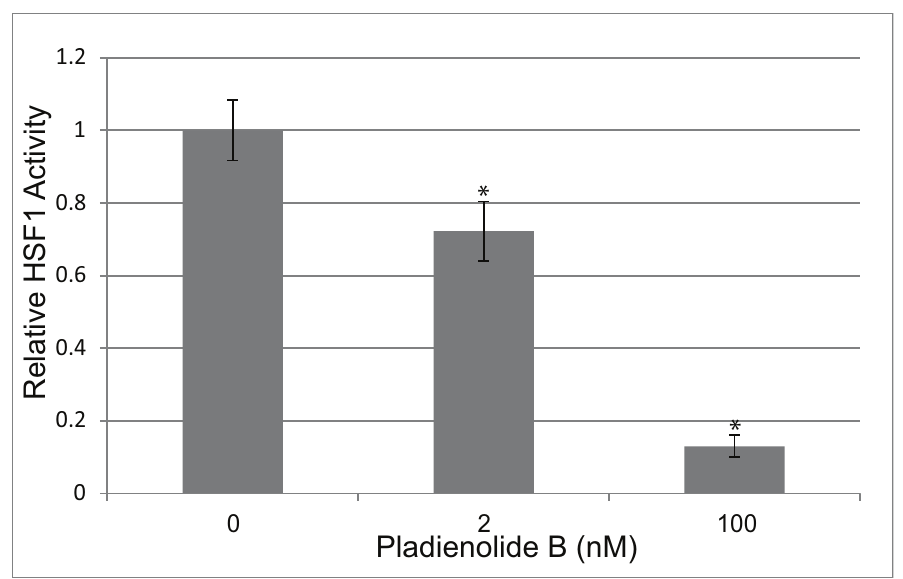
Fig 4. Inhibition of SF3B1 affects HSF1 transcriptional activation. Quantitationof relativeluminescence from cells expressingan HSF1-Gal4 chimeracontainingthe HSF1 activationdomainand the Gal4 DNA- bindingdomainexposedto varying levels of Pladienolide B. Luciferase activity was monitored from a firefly luciferase reporter with a Gal4 bindingelementthat was co-transfected with the chimera. Luciferase activity was normalized to the no drug control and a VP16-Gal4 control. Dual luciferase with a generalNanoLuc reporter was also measuredto correct for differencesin cell density and transfectionefficiency. * indicates p- value <